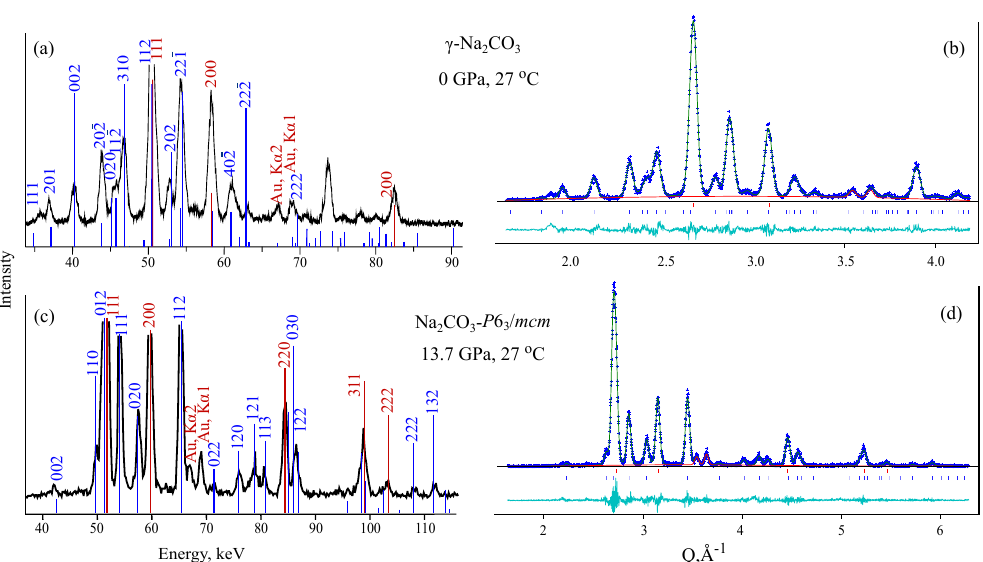
Figure 2. Indexing of diffraction patterns with γ - ( a ) and P 6 3 / mcm ( c ) structures of Na 2 CO 3 and corresponding Pawley refinements ( b , d ). Blue bars correspond to the theoretical peaks of γ -Na 2 CO 3 ( a , b ) and Na 2 CO 3 - P 6 3 / mcm , red bars-to the peaks of Au.